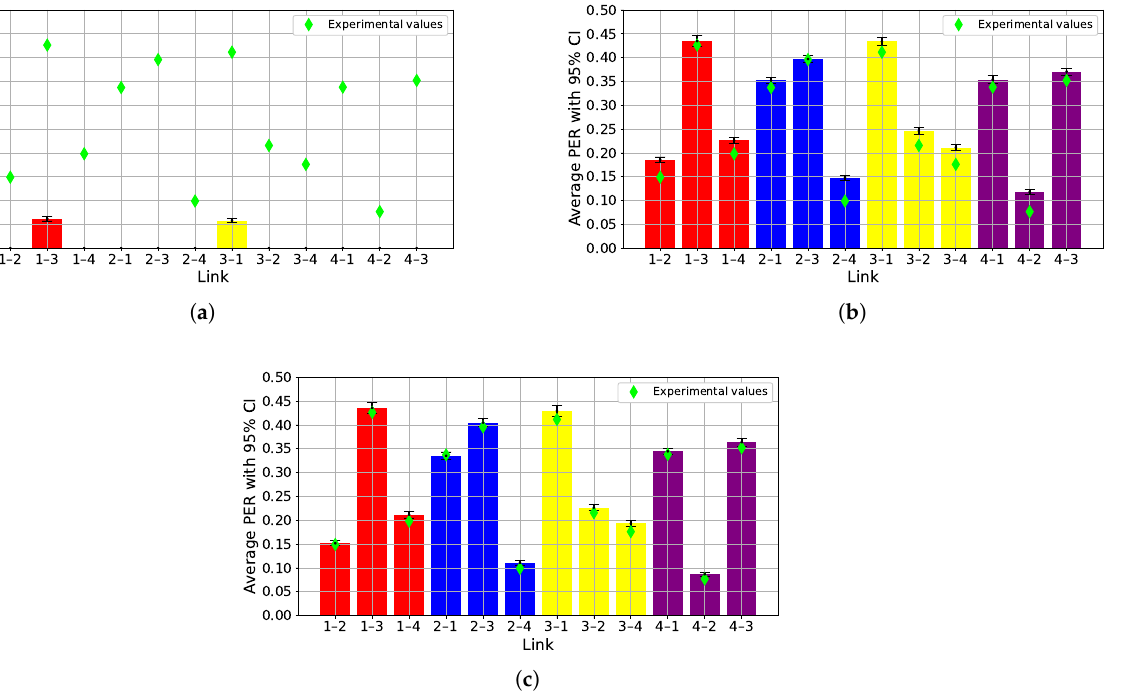
Figure 9. PER results yielded by the simulations (bars) with respect to Haifa Harbor measurements (green diamond) for UWPhysical ( a ), UWHMMPhysical ( b ), and UWHMMPhysicalExt ( c